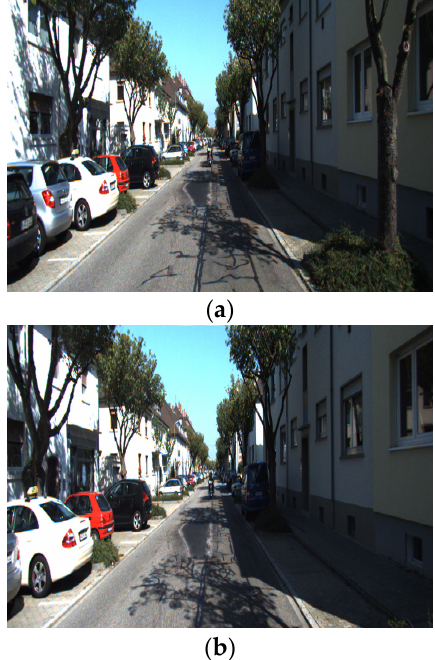
Figure 5. The image pair with high similarity. ( a , b ) are two images extracted from the video stream, which look almost identical.